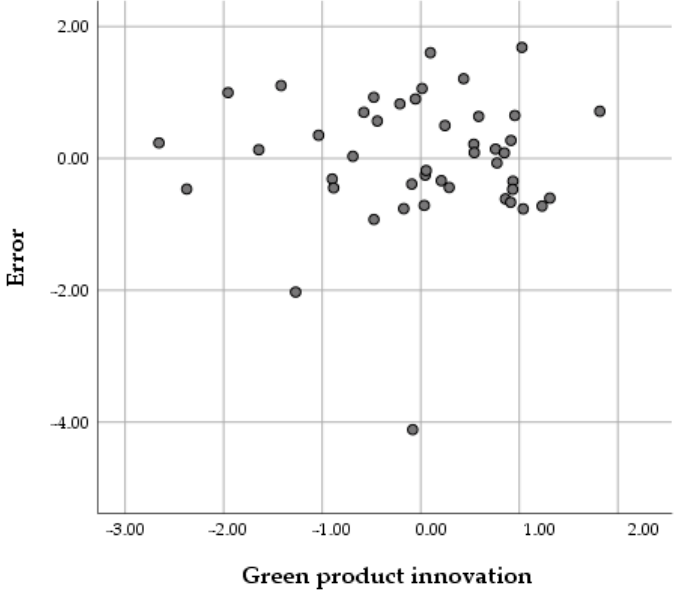
Figure 5. Regression error and green process innovation scatter plot.